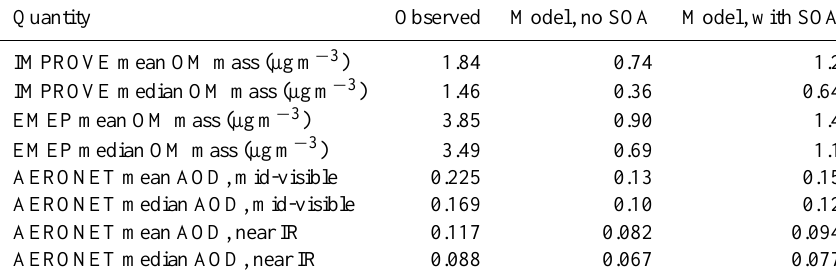
Table 3. Comparison of model results with mean and median observed quantities.